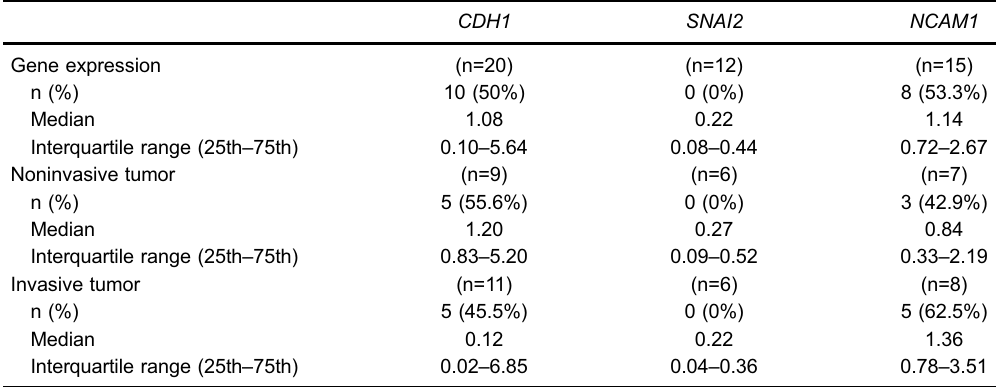
Table 2. Gene expression of ECAD ( CDH1 ), SLUG ( SNAI2 ) and NCAM ( NCAM1